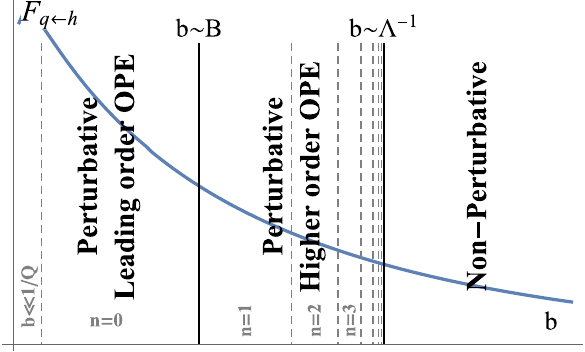
Fig. 1 (left) The evolution plane (μ,ζ) and paths for the evolution integrals from (μ f ,ζ f ) to (μ i ,ζ i ) . Gray lines are equi-evolution lines ζ μ atdifferent b .Paths1and2reprentthesolutionsinEqs.(19)and(20), corespondingly. These solutions are equivalent to the evolution to the